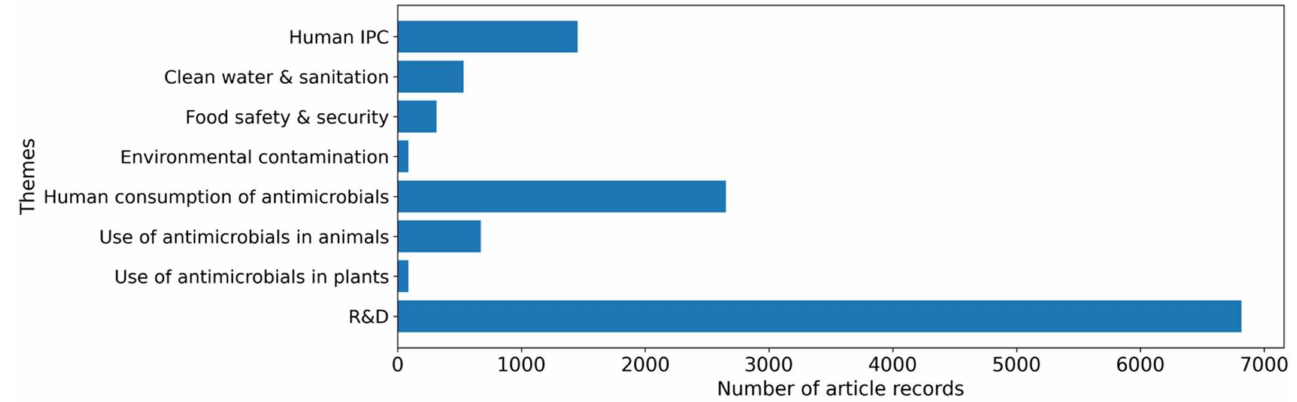
Figure 3. Overview of the primary theme (human infection and prevention control (IPC); research and development (R&D)) distribution among the article records ( n =